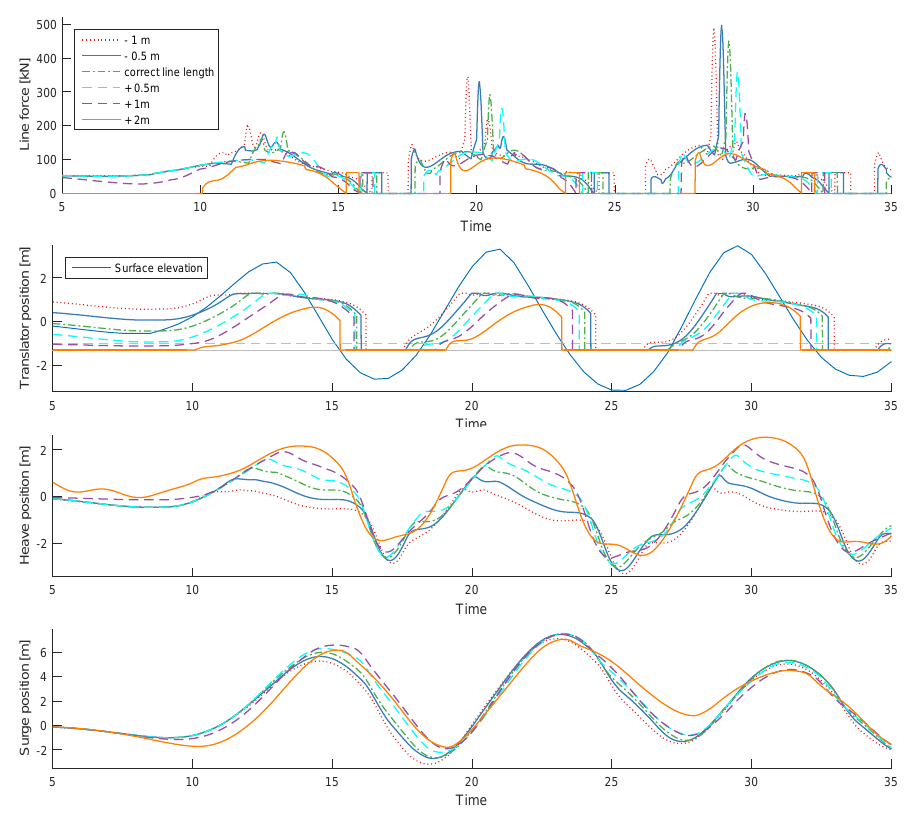
Figure 15. A regular wave was modeled, comparing the influence of different line